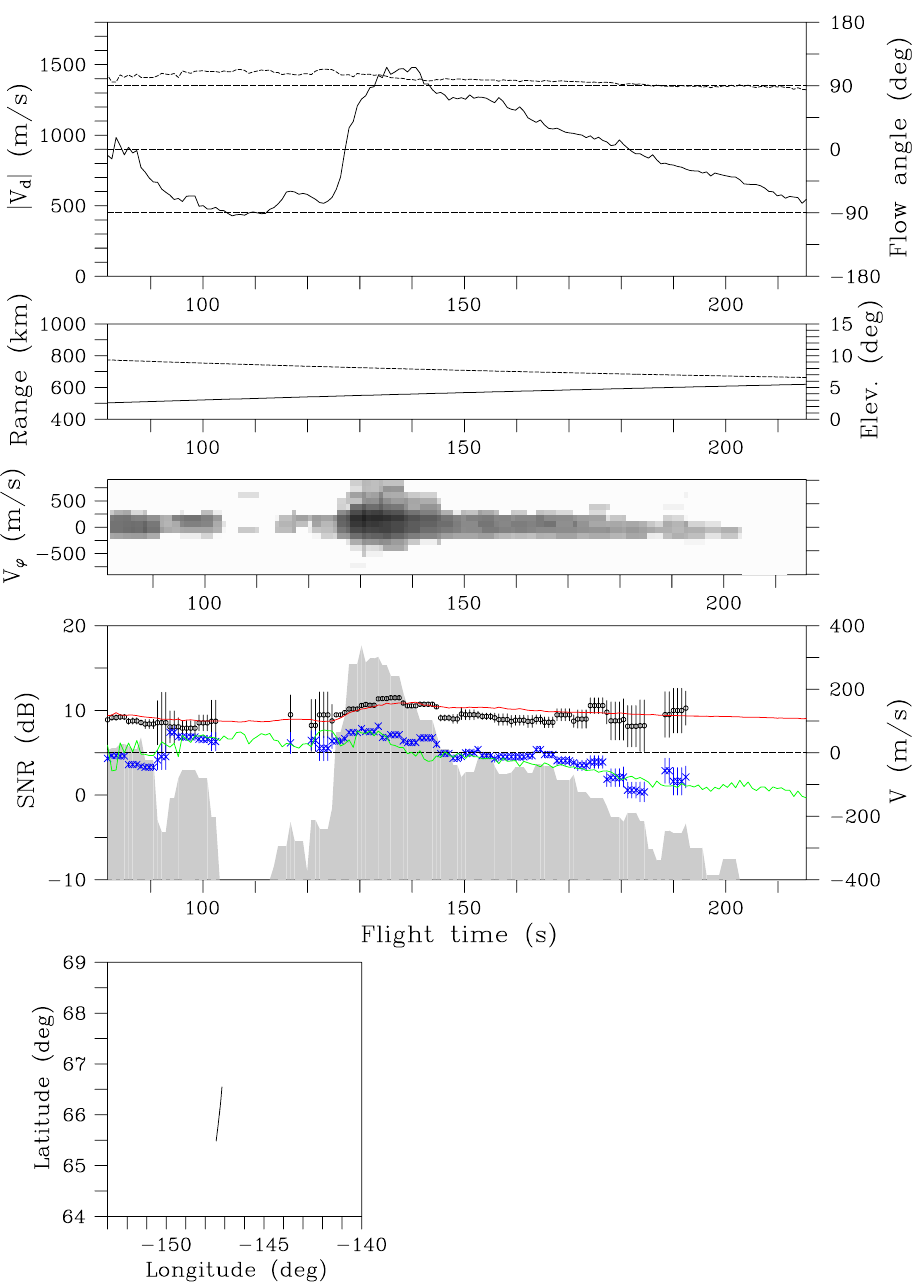
Fig. 5. Comparison of rocket and coherent scatter radar data. T0=12:29:00UT. First panel: rocket-derived convection speed (solid line) and direction (dashed line) as seen from the radar point of view. Second panel: range (solid line) and elevation angle (dashed line) of corresponding volume from the radar point of view. Third panel: radar spectrogram. Fourth panel: coherent scatter power (gray field), Doppler shift (x), and spectral width (o). Green and red lines represent theory (see text). Fifth panel: coordinates of the region sampled by the rocket, mapped along geomagnetic field lines to 100 km